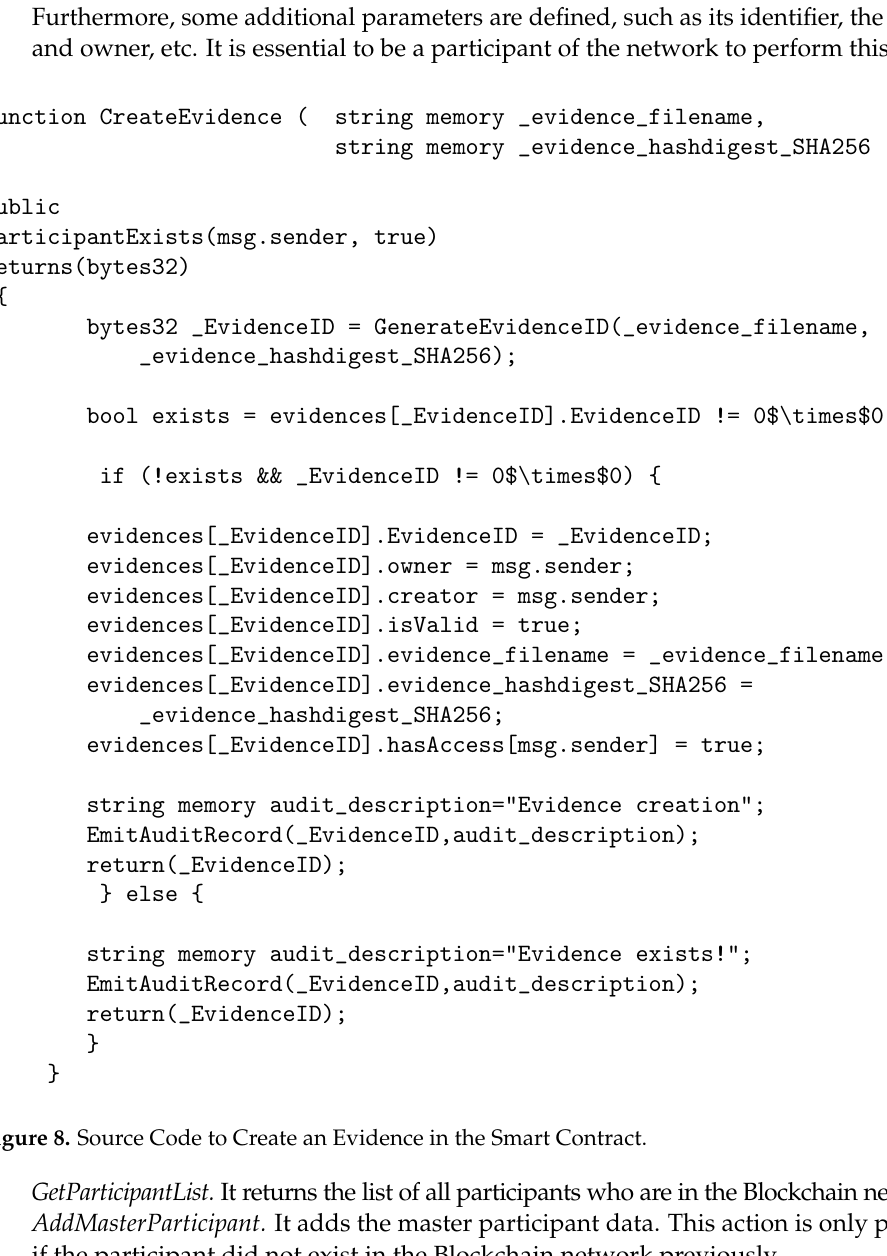
Figure 8. Source Code to Create an Evidence in the Smart